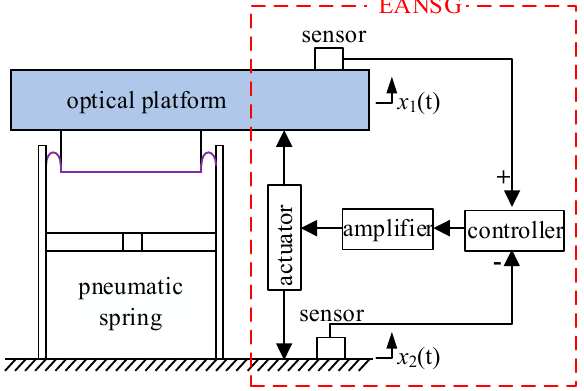
Figure 1. Scheme of electromagnetic active-negative stiffness generator (EANSG).